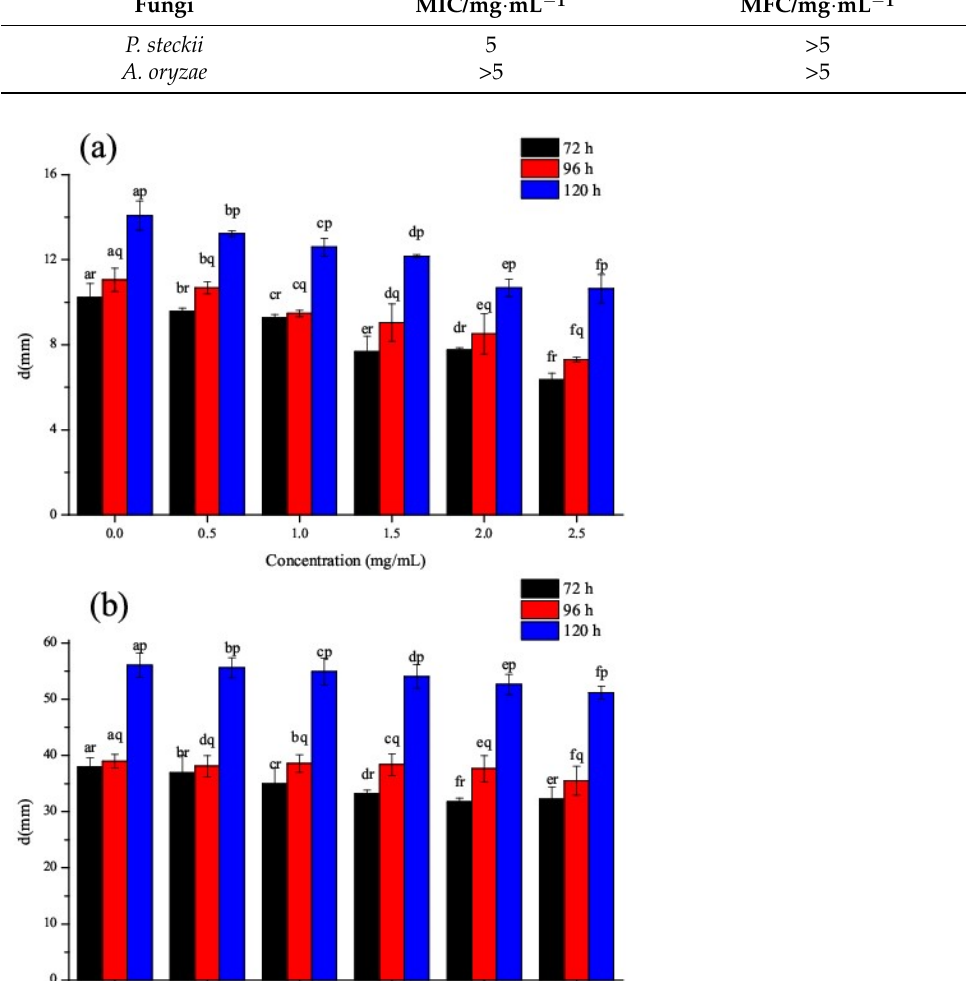
Table 2. The MIC and MFC of CSNPs against P. steckii and A. oryzae . Fungi